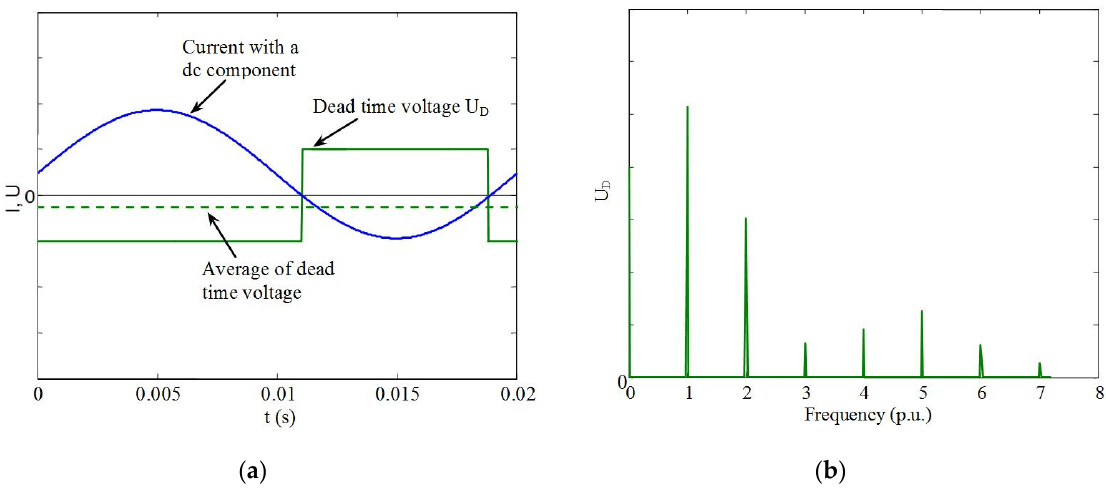
Figure 7. Dead time voltage in a presence of a DC component in a phase current: ( a ) time course; ( b ) spectrum [1].